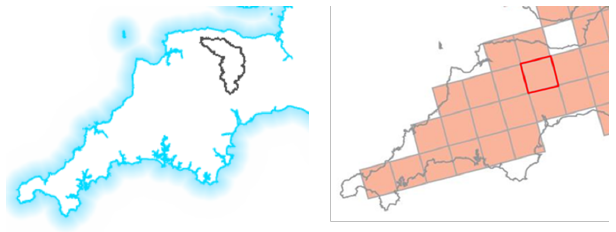
Figure 1. Location of the Thorverton catchment (the left panel) and HadRM3 25km grid boxes (the right panel). The highlighted grid box in red is selected to cover the Thorverton